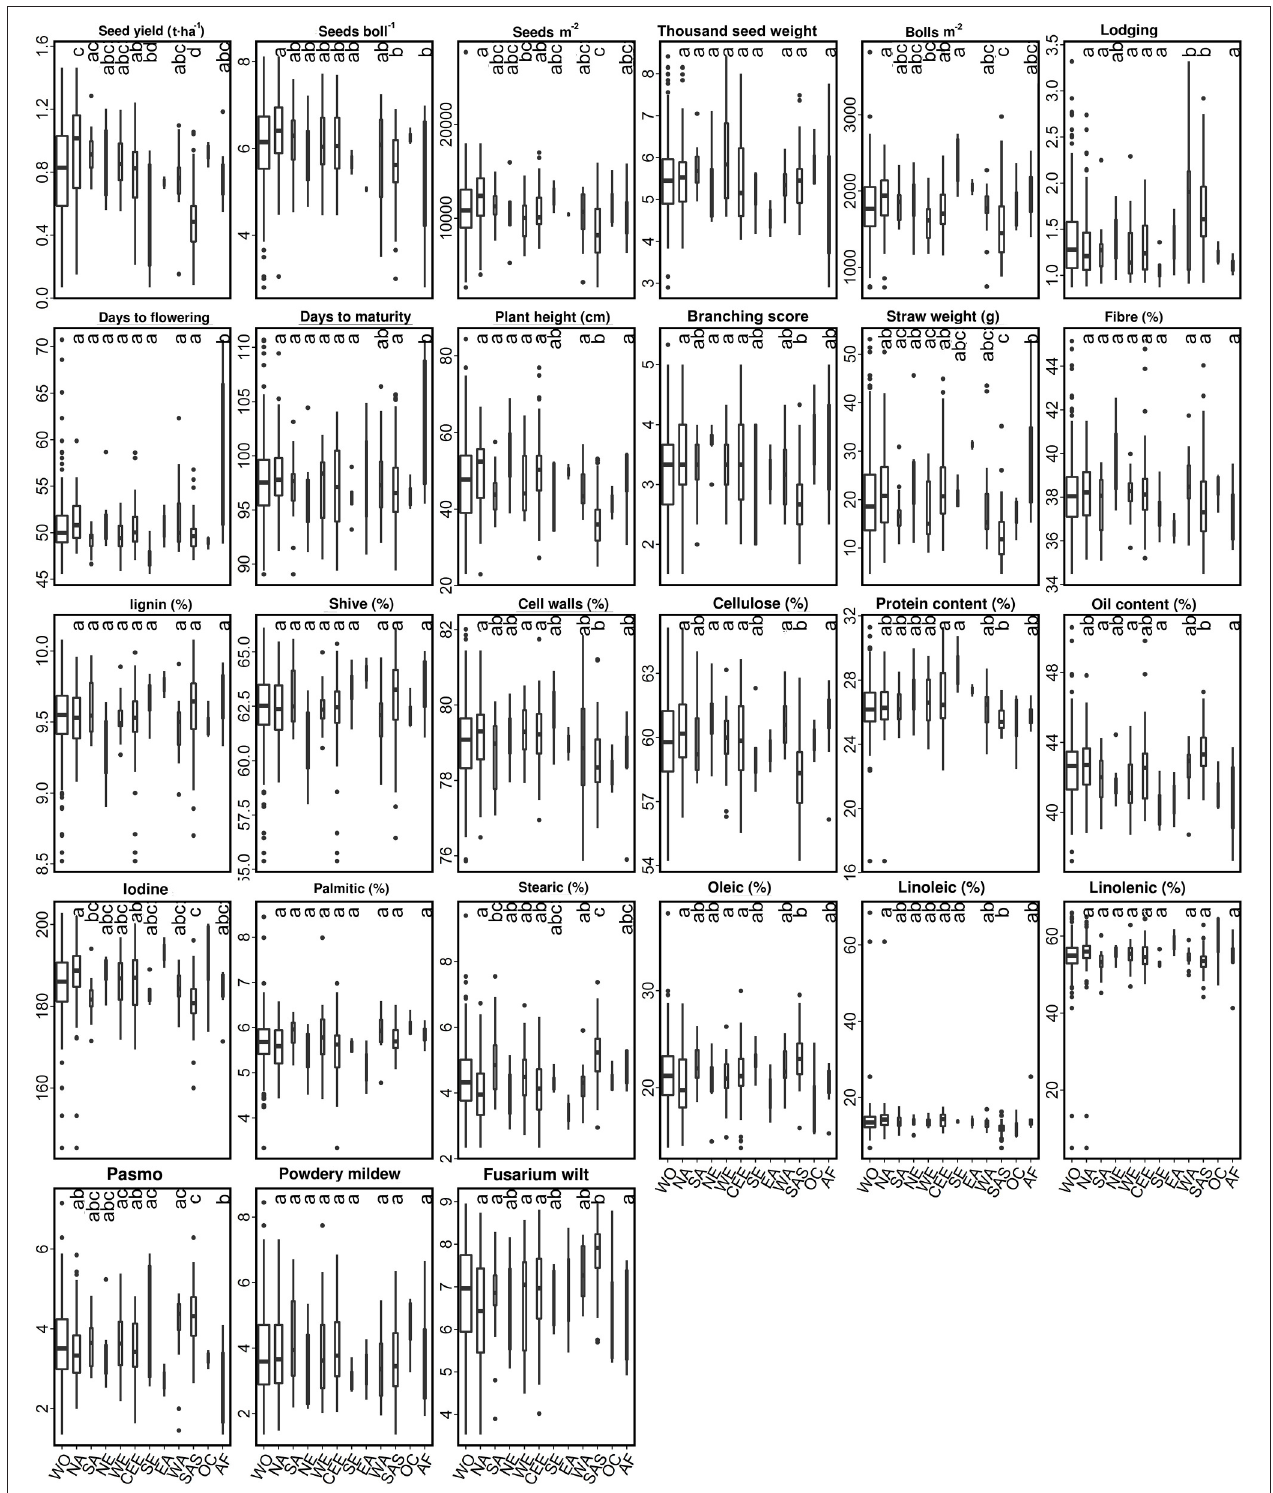
FIGURE 5 | Box plots of 27 traits of the 299 linseed accessions of the core collection in relation to their geographical origin. Different letters at the top of each boxplot represent statistical significance at the 5% probability level among the nine geographical regions with five or more accessions. See Figure 4 for abbreviations and other